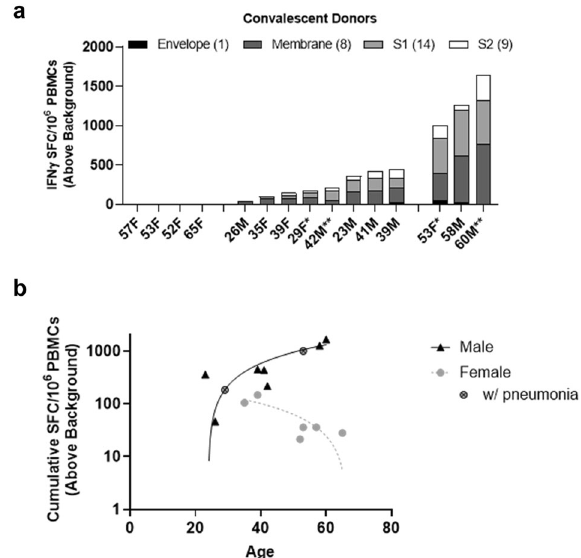
Fig. 2 SARS-CoV-2 experienced individuals exhibit variable immune recall responses ex vivo. a Signi fi cant responses to individual peptides (combined per source antigen) identify three distinct immunotype cohorts within covalescent donors (donor notations: *pneumonia, **hospitalized, non-ICU). b Correlation of cumulative T-cell responses and age according to gender. Male cohort ( n = 7, R 2 = 0.7571, p = 0.0109). Female cohort ( n = 8, R 2 = 0.00001, p = 0.9934). Mild subset of female cohort ( n = 6, R 2 = 0.7034, p =